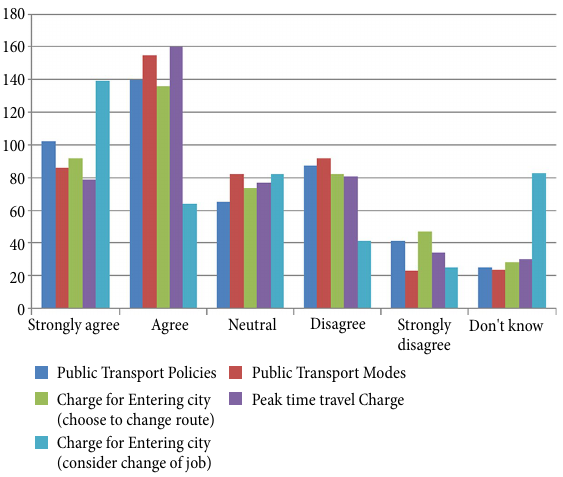
Fig. 4. Graph of findings in relation to respondents’ acceptance of transport policy